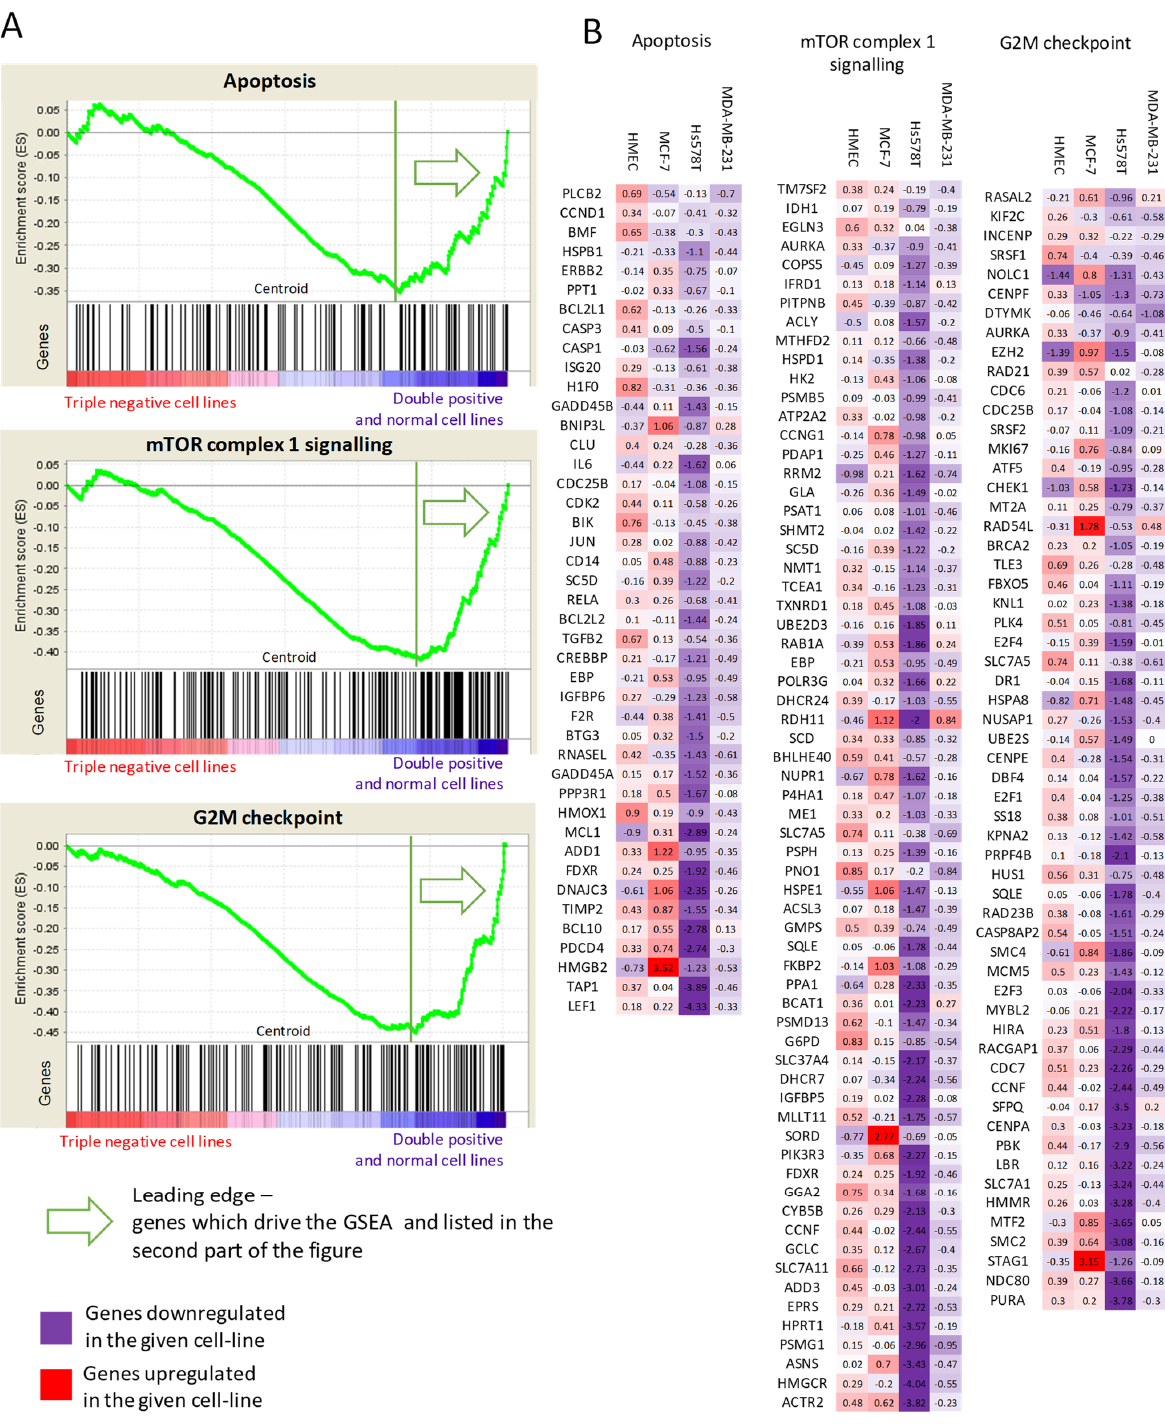
Figure 5. Gene Set Enrichment Analysis. ( A ) Genes in TNBC vs. DPBC and normal cell lines are perturbed differently after arsenate treatment with respect to apoptosis, mTOR signaling and G2M checkpoint signaling ( q < 0.15). ( B ) Lists of genes differentially expressed per cell line belonging to the above pathways are colored by their differential expression. It can be seen that apoptosis, mTOR signaling and G2M checkpoint regulating genes are downregulated in the TNBC cases after arsenate treatment, while they are upregulated or not changed in the DPBC and in HMEC cell lines. The full results can be seen in Table S4.